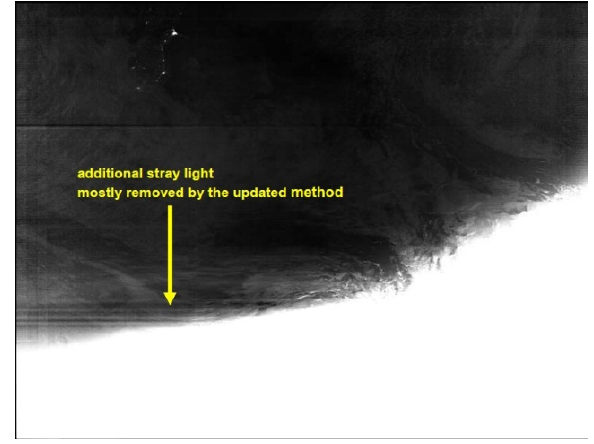
Figure 11. DNB image from October 5, 2013, 5:06 GMT, corrected by the updated method. The residual artifact from additional stray light is significantly reduced.